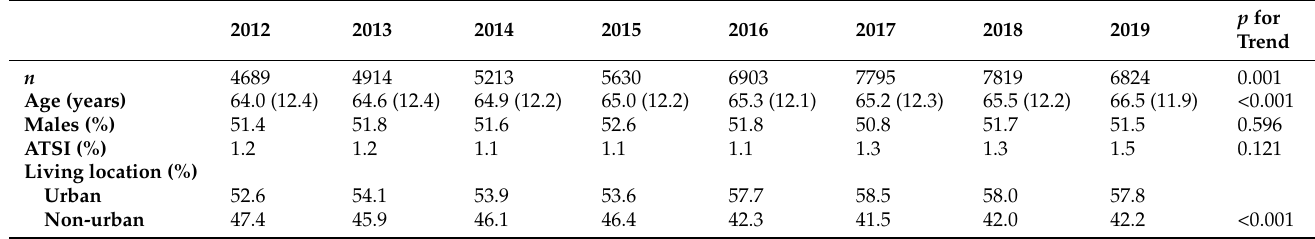
Table A5. Demographics of patients taking lipid-lowering medications at different timepoints in the ePBRN cohort.